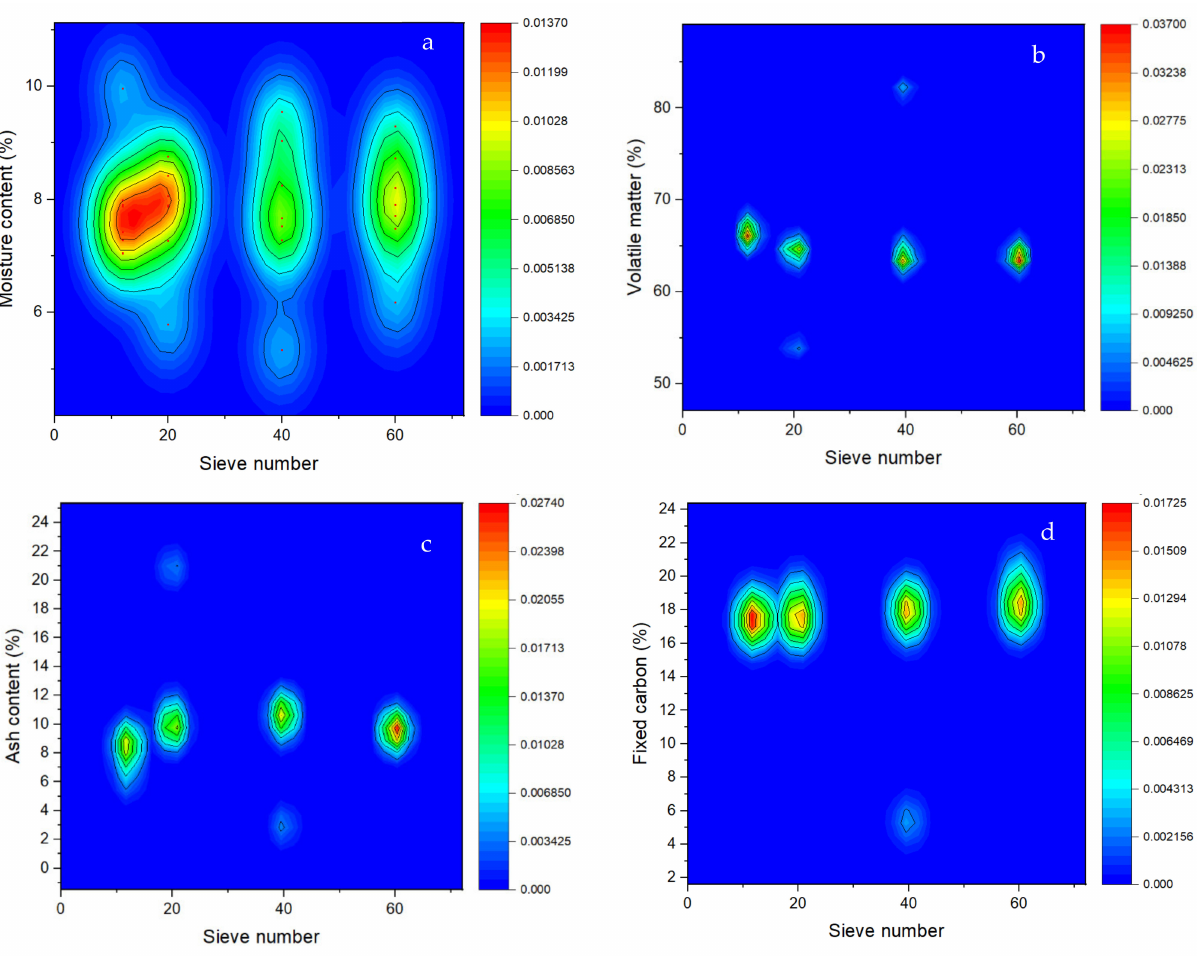
Figure 1. Results of the proximate analyses of pecan pericarp wastes of different particle sizes: 1.6 mm (N ◦ 12), 0.84 mm (N ◦ 20), 0.42 mm (N ◦ 40) and 0.25 mm (N ◦ 60). ( a )—Moisture content, ( b )—Volatile matter, ( c )—Ash content, ( d )—Fixed